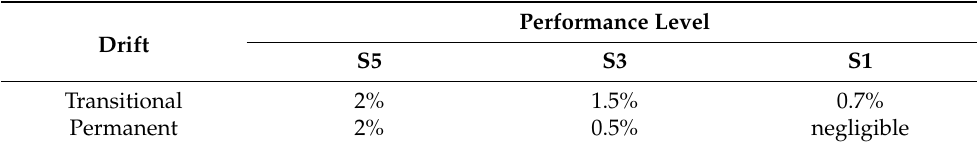
Table 1. FEMA274 drift